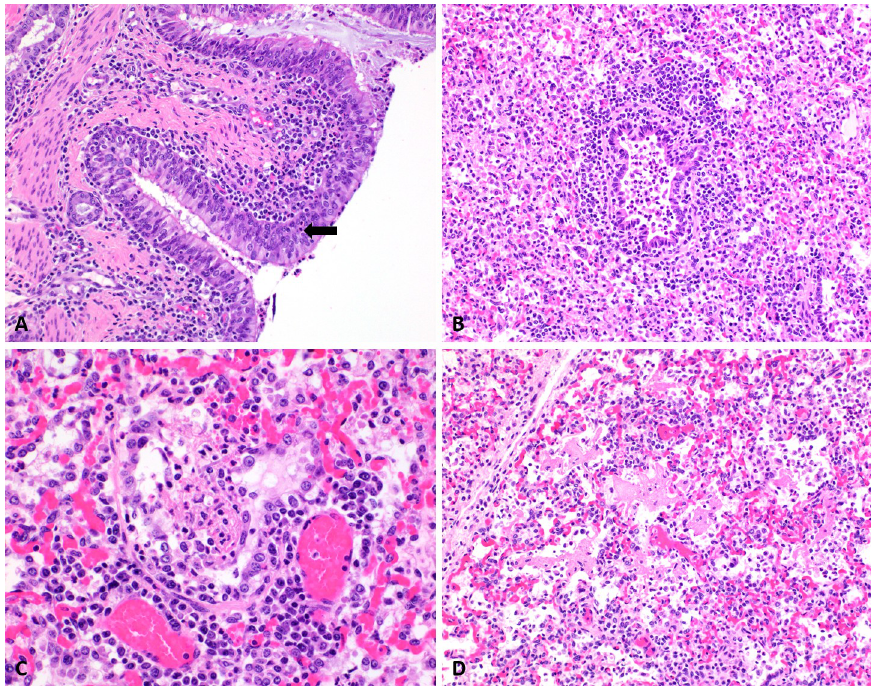
Fig 9. Photomicrographs demonstrating the histological changes encountered. Panel A. The bronchial submucosa is moderately expanded with lymphocytes, plasma cells and occasional macrophages. Hematoxylin and eosin, 20X. Panel B. In the center, there is a bronchiole containing viable and degenerate neutrophils and a few macrophages. The periphery of the bronchiole is infiltrated with moderate numbers of lymphocytes, plasma cells and macrophages. The rest of the pulmonary parenchyma is atelectatic, with edema and mixed inflammatory cells within alveolar spaces. Hematoxylin and eosin, 20X. Panel C. The bronchiolar lumen contains a fibrin plug with a few entrapped neutrophils and macrophages. This structure is being covered with a low cuboidal to flattened epithelium. This finding was interpreted as early bronchiolitis obliterans. There are small numbers of lymphocytes and plasma cells at the periphery of this bronchiole. Hematoxylin and eosin, 40X. Panel D. Within alveoli, there are moderate numbers of neutrophils and macrophages, together with abundant eosinophilic fibrillary material (fibrin). Alveolar septa are moderately thickened with mononuclear cells. Hematoxylin and eosin, 20X. The S1 File includes additional photomicrographs and the full scoring scheme